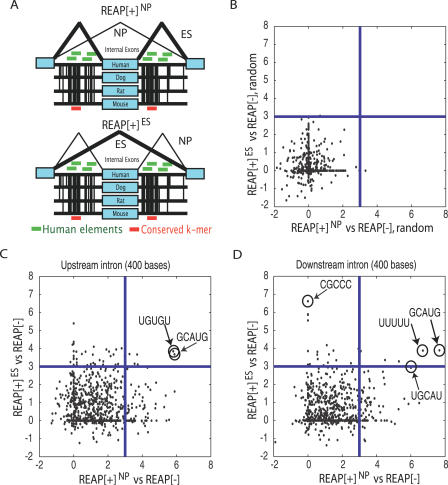
Conserved Intronic cis-Elements Enriched Proximal to REAP[+] Alternative Exons(A) Schematic describing the enumeration of intronic elements across 400 bases of flanking mammalian introns (human, dog, rat, and mouse). Red and green horizontal bars represent conserved intronic elements and nonconserved elements, respectively. Internal exons were divided into REAP[+]NP, REAP[+]ES, and REAP[−] exons. The χ statistic was computed to represent the enrichment of conserved elements in intronic regions flanking REAP[+]NP versus REAP[−] exons (x-axis), and REAP[+]ES versus REAP[−] exons (y-axis). The sign represented the direction of change, i.e., positive if enriched in introns flanking REAP[+] versus REAP[−] exon. Each conserved 5-mer was associated with two numbers: the enrichment in introns proximal to REAP[+]NP versus REAP[−] exons (x-axis), and REAP[+]ES versus REAP[−] exons (y-axis).(B) Downstream intronic regions, where the association between REAP[+] designation and the exons was shuffled.(C) Upstream intronic regions. Circled 5-mers in the upper right quadrant represent conserved 5-mers enriched in the upstream intronic regions of REAP[+]NP and REAP[+]ES exons.(D) Downstream intronic regions. Circled 5-mers in the upper right quadrant represent conserved 5-mers enriched in the downstream intronic regions of REAP[+]NP and REAP[+]ES exons.